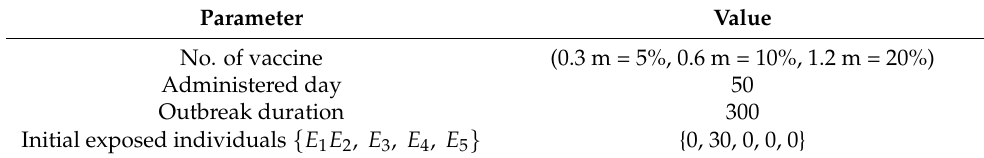
Table 8. Experimental parameter